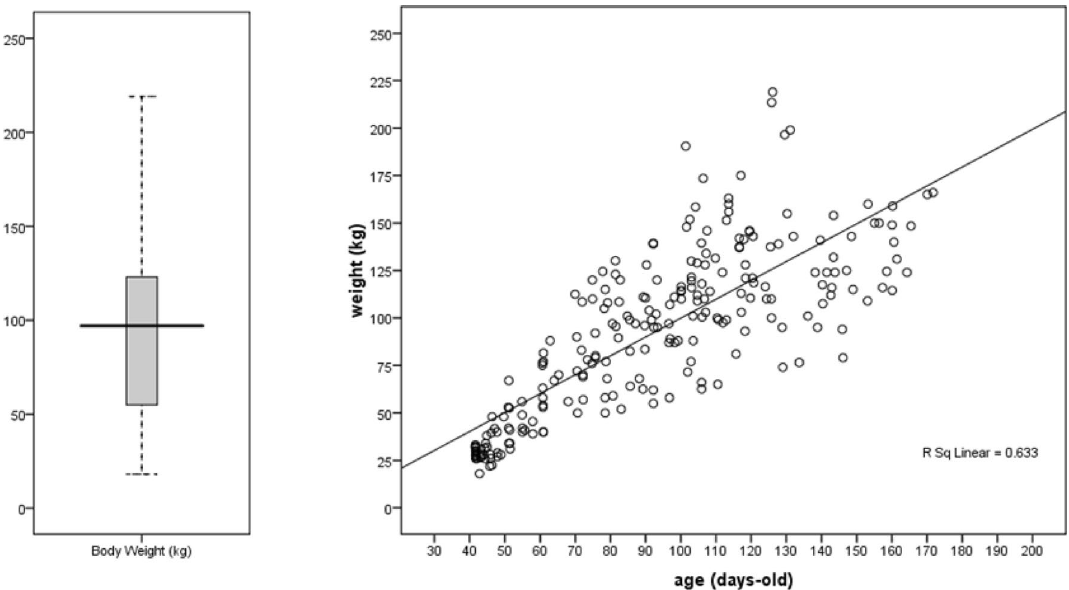
Figure 2. Box plot of 255 body weight records (left plot) and growth trend (right plot) of 96 dromedary camels in five regions of the central desert of Iran.